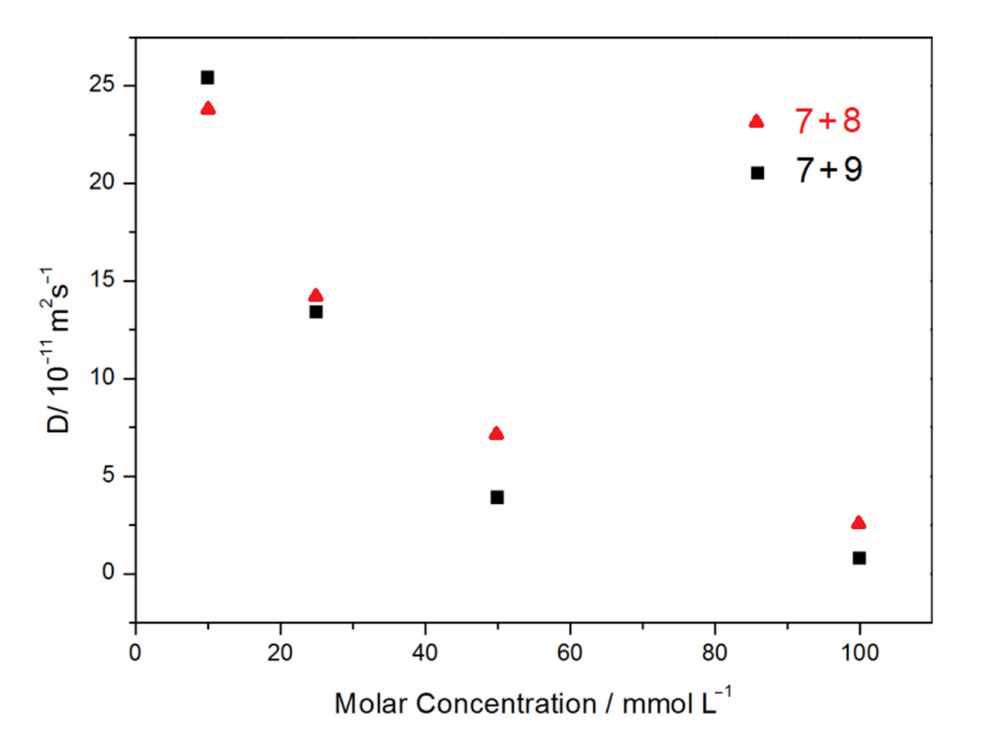
Figure 7. Concentration dependence of diffusion coefficient D [500 MHz, CD 2 Cl 2 /CD 3 NO 2 (1 1, v / v ), 298 K] of the linear ( 7 + 8 ) and the cross-linked ( 7 + 9 ) supramolecular